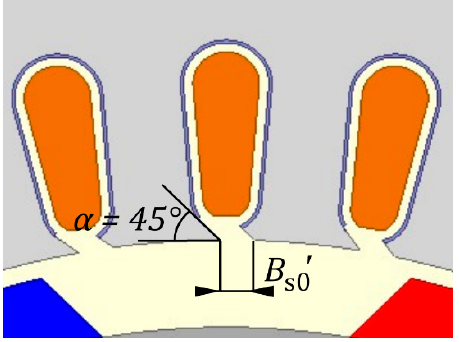
Figure 15. Fragment of a field model with oblique slot opening.